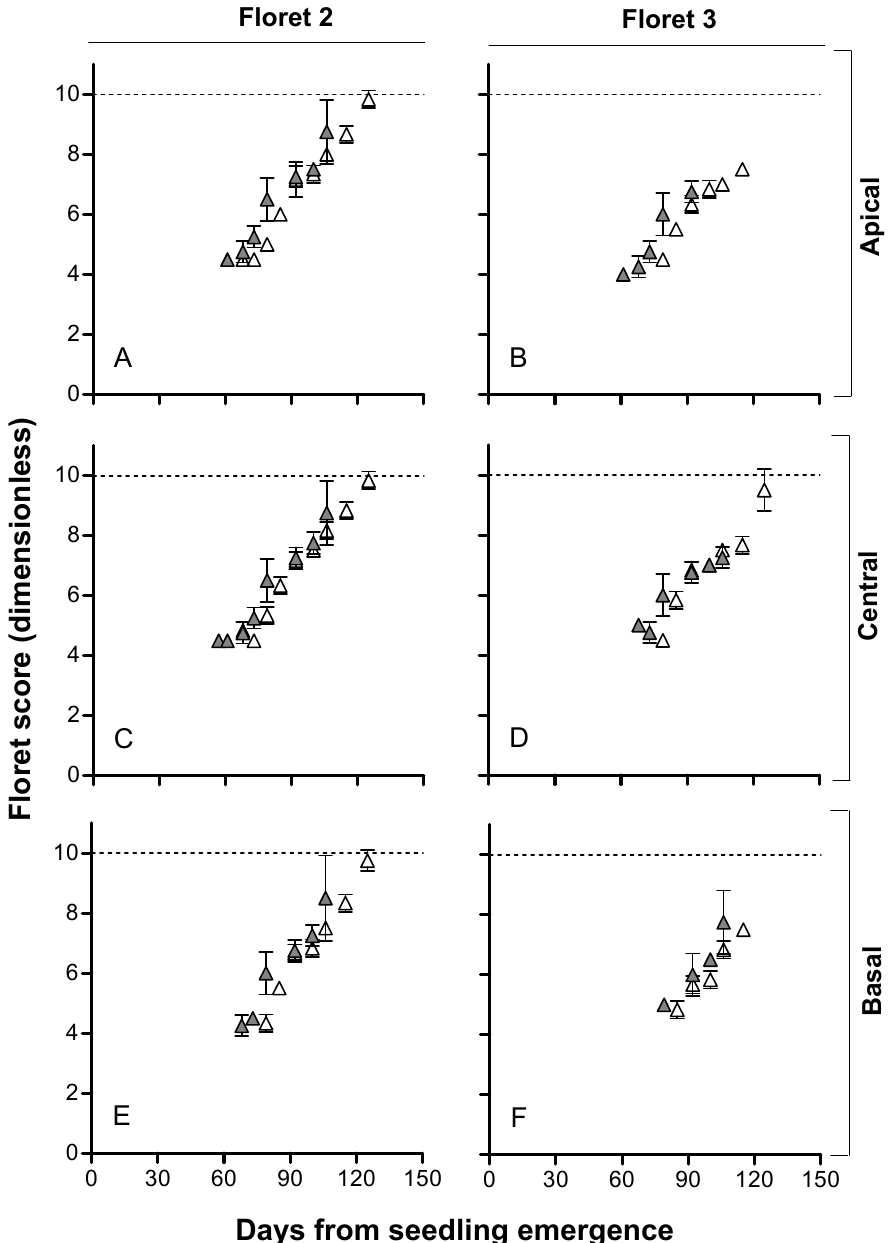
Figure 6. Relationship between floret development as the floret score (dimensionless) and days from seedling emergence for Eps-7D-late (open symbols) and - early (closed symbols) with sensitive allele for Ppd-D1 ( Ppd-D1b ) in the background at 15 °C for F2 ( A , C , E ) and F3 ( B , D , F ) in spikelets from apical ( A , B ), central ( C , D ) and basal ( E , F ) positions of the spike. The error bars are SEMs from floret scores of replicated plants (not visible when smaller than the symbol size).